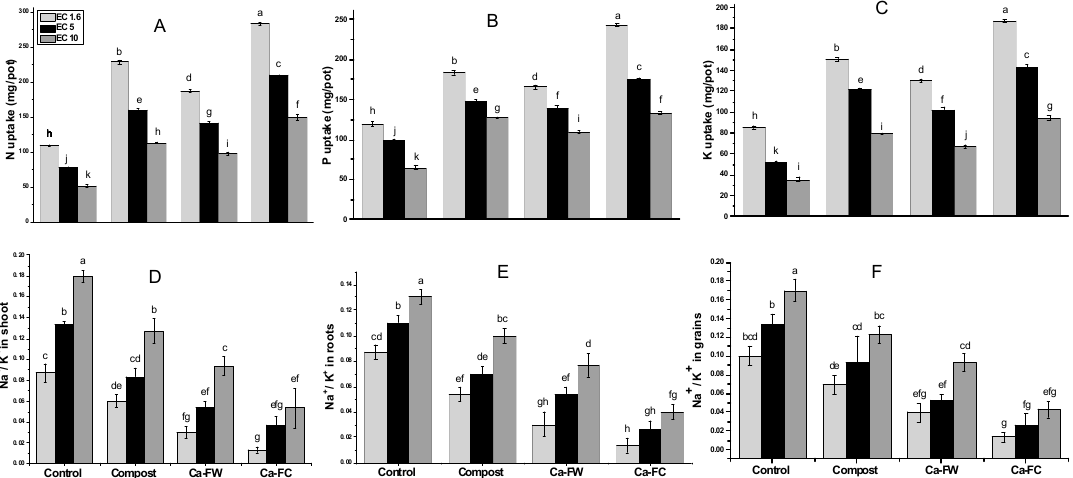
Figure 4. E ff ect of compost, Ca-FW, and Ca-FC on nutrients homeostasis of maize ( Zea mays L.) under saline–sodic soil conditions. (Note: Ca-FW = calcium based fertilizer industry waste; Ca-FC = calcium-fortified compost. Quantities sharing similar letters are statistically di ff erent from each other at p ≤